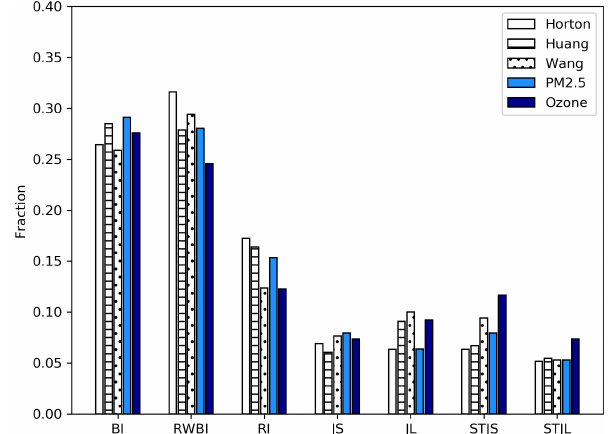
Figure 10. The dynamical indices included as predictors by the stepwise procedure in the MLR models of the three ASIs and two pollutants. The fraction of total predictors across all seasons and re- gions that are blocking (BI), Rossby wave breaking (RWBI), ridge (RI), eddy-driven jet speed (JS) and latitude (JL), and subtropical jet speed (STJS) and latitude (STJL) are shown for each